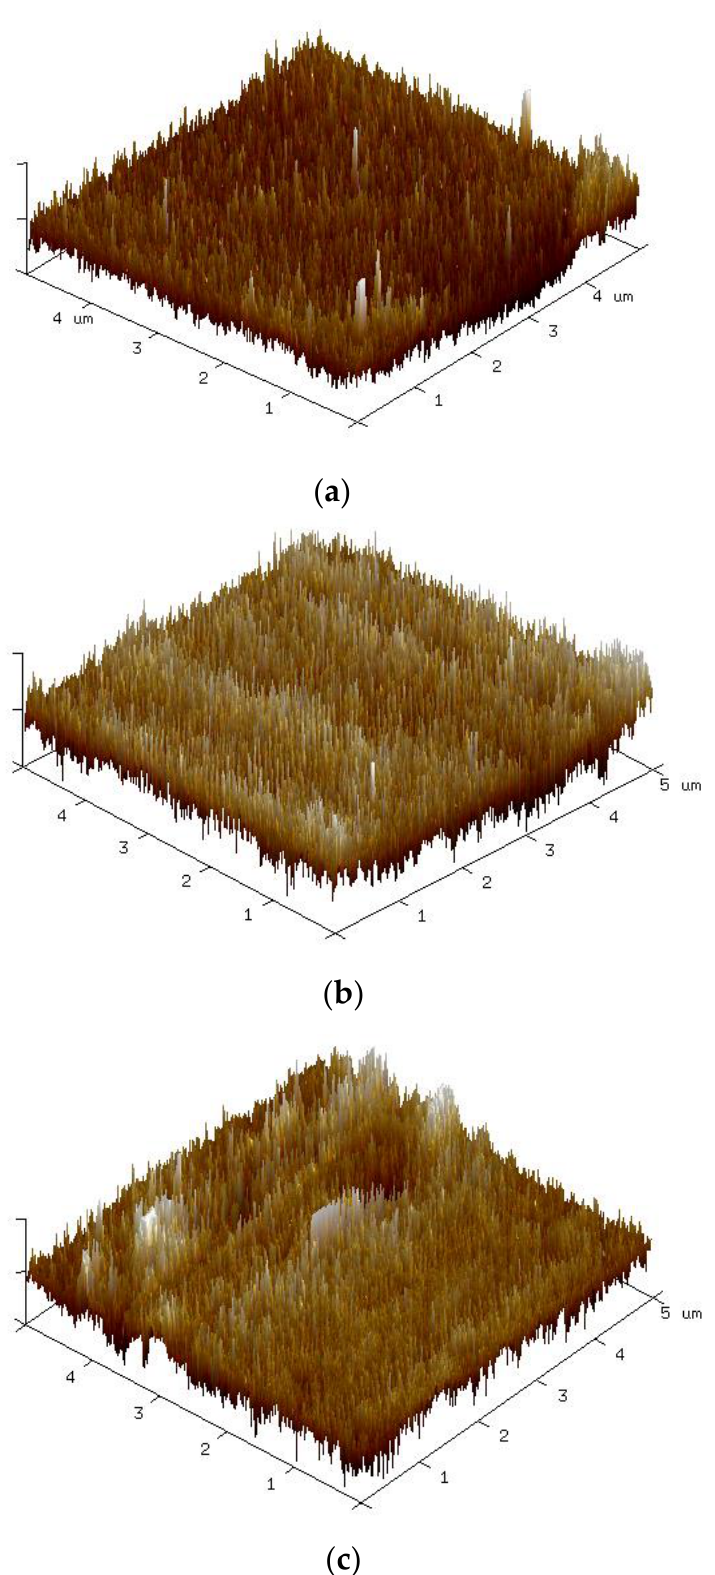
Figure 10. Three-dimensional surface contour diagrams of PI substrates subjected to different durations of air plasma modification: ( a ) 10 min, ( b ) 15 min, and ( c ) 20 min.